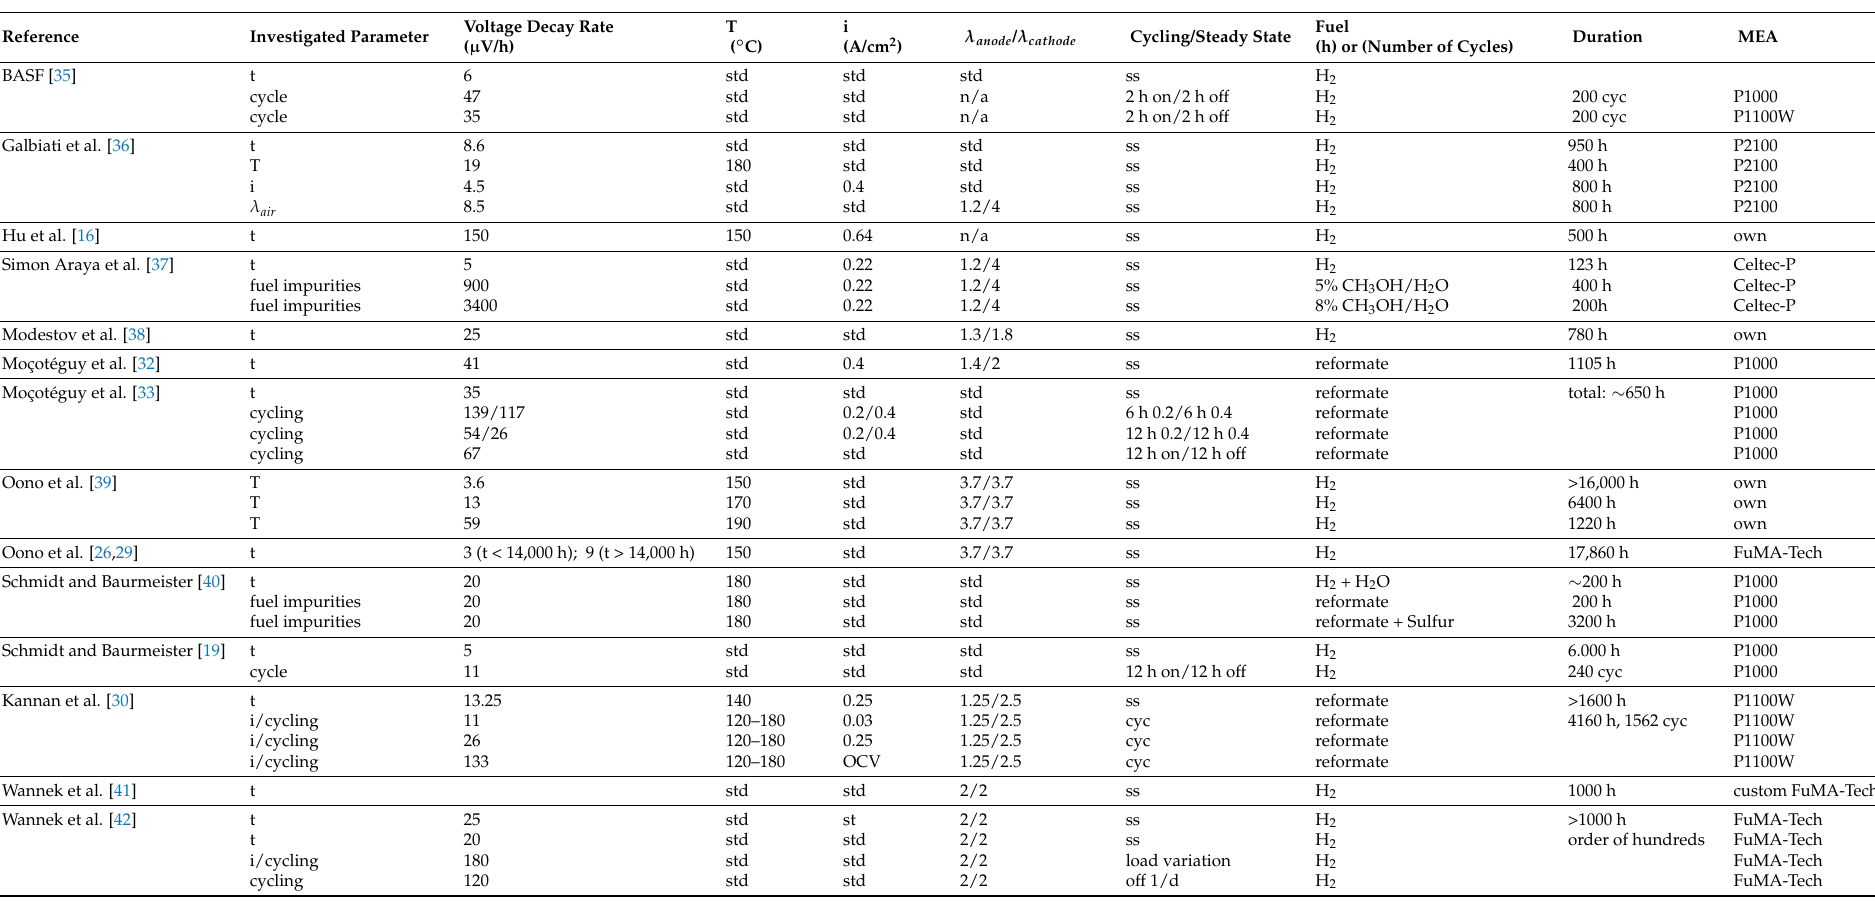
Table 1. Literature survey of HT-PEMFC degradation data. std represents recommended standard operating conditions (160 °C, 0.2 A / cm 2 , 1 atm, λ anode / λ cathode = 1.2/2), ss is steady state operation, t is time (durability test), T is temperature, cyc is cycling operation and reformate refers to the hydrogen-rich gas produced during methanol-steam reforming